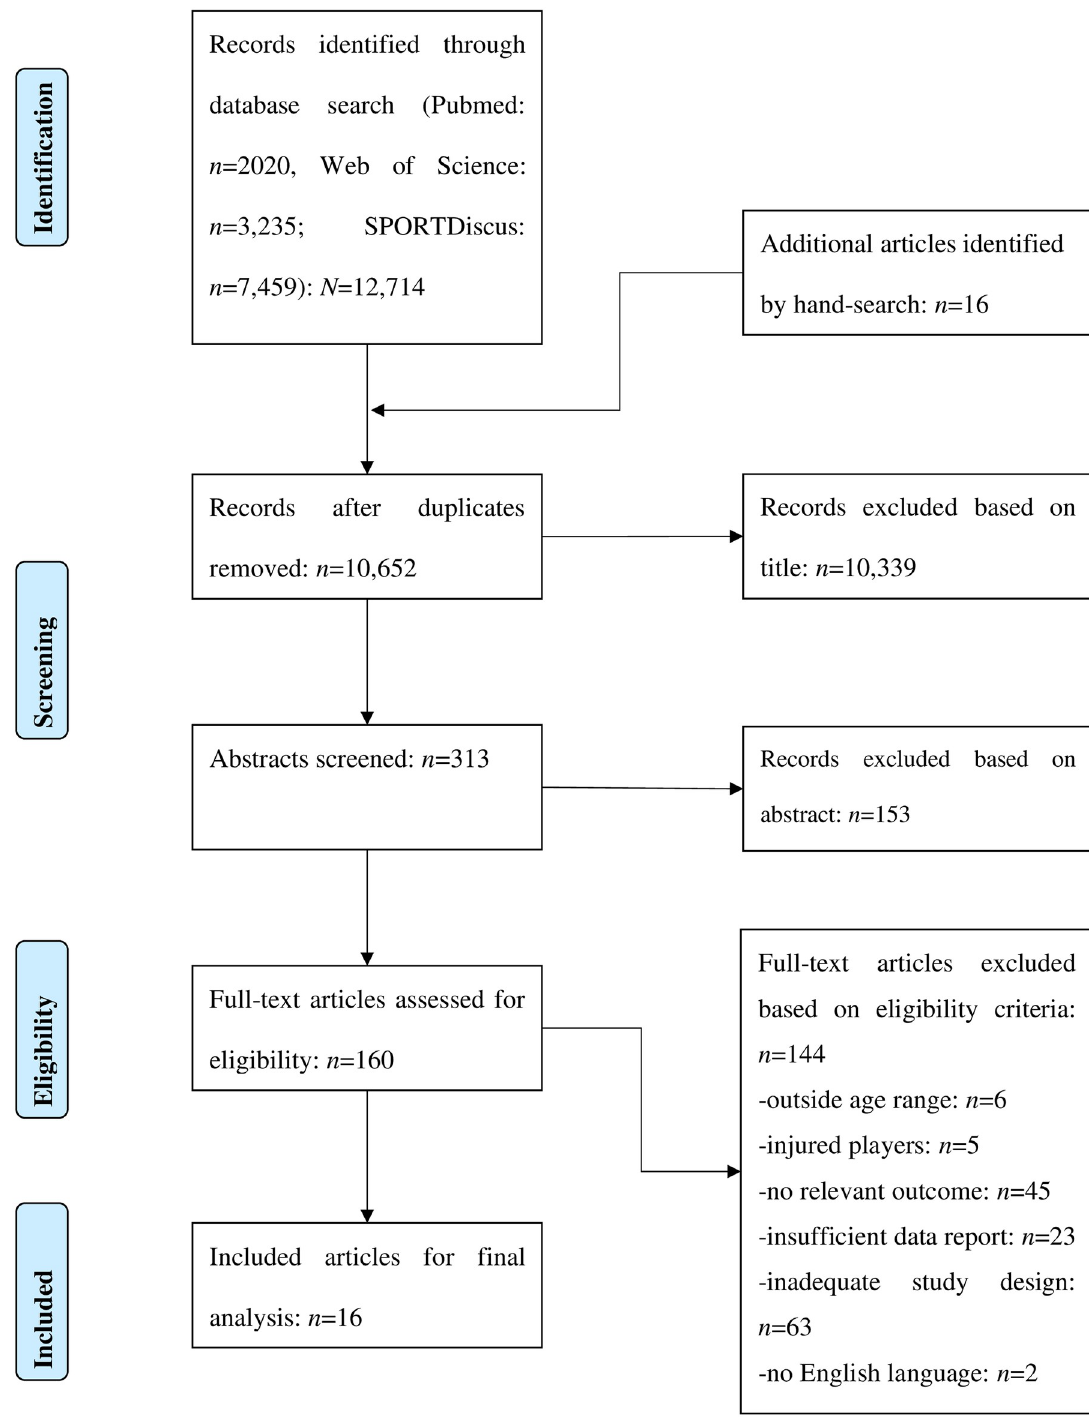
Fig 1. PRISMA flow chart illustrating the different phases of literature search, study selection, and reasons for exclusion of records.